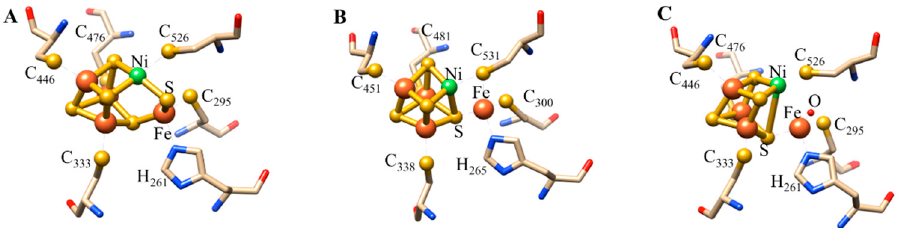
Figure 4. Structures of [Ni-Fe]-CODH from different sources, [Ni,3Fe-5S] ( A ) from CODH Ch (PDB file 1SU6), [Ni,3Fe-4S] ( B ) from CODH Rr (PDB file 1JQK) and [Ni,3Fe-4S-O] ( C ) from CODH-II Ch (PDB file 3B53).